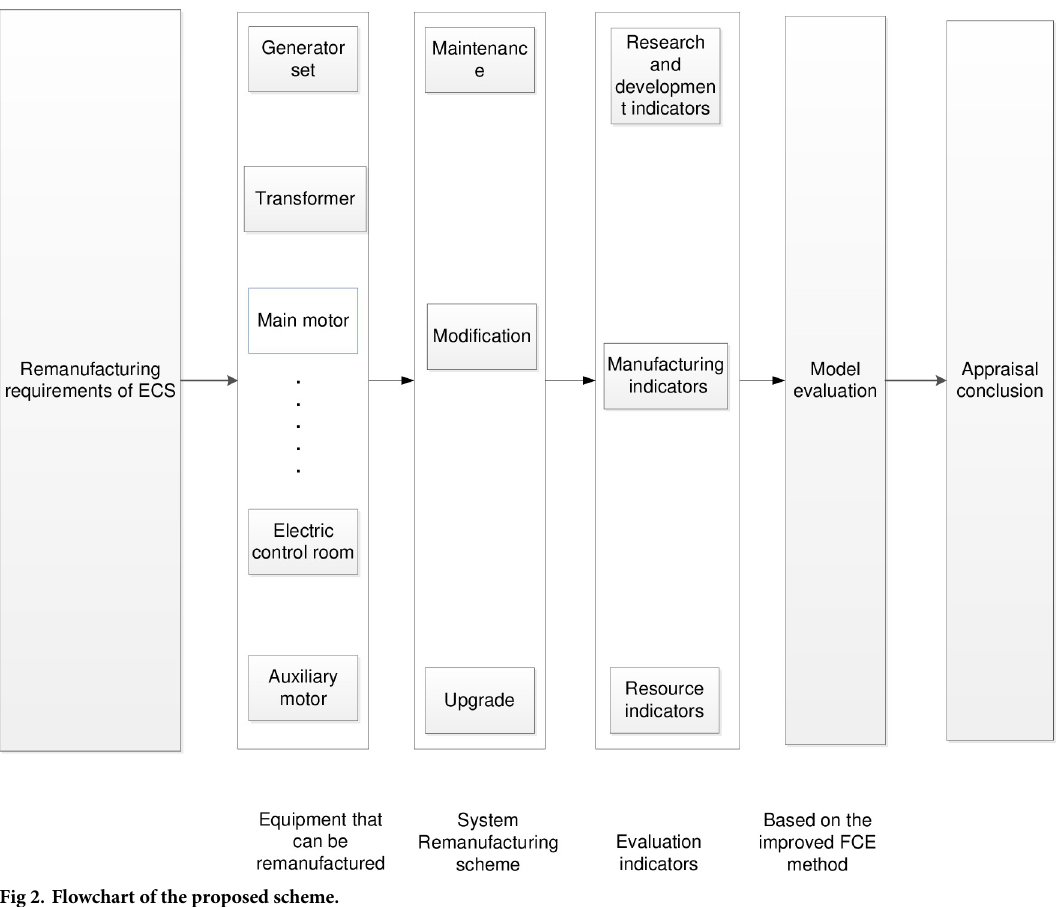
Fig 2. Flowchart of the proposed